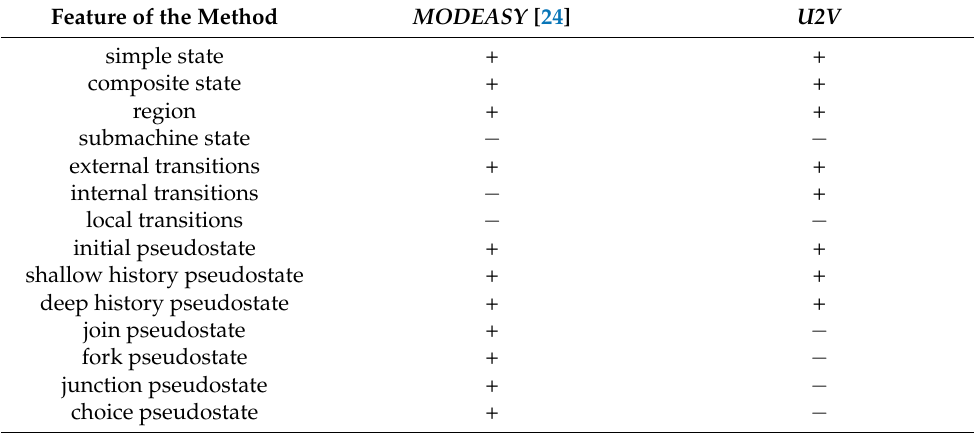
Table 2. A comparison of the MODEASY [24] with the U2V